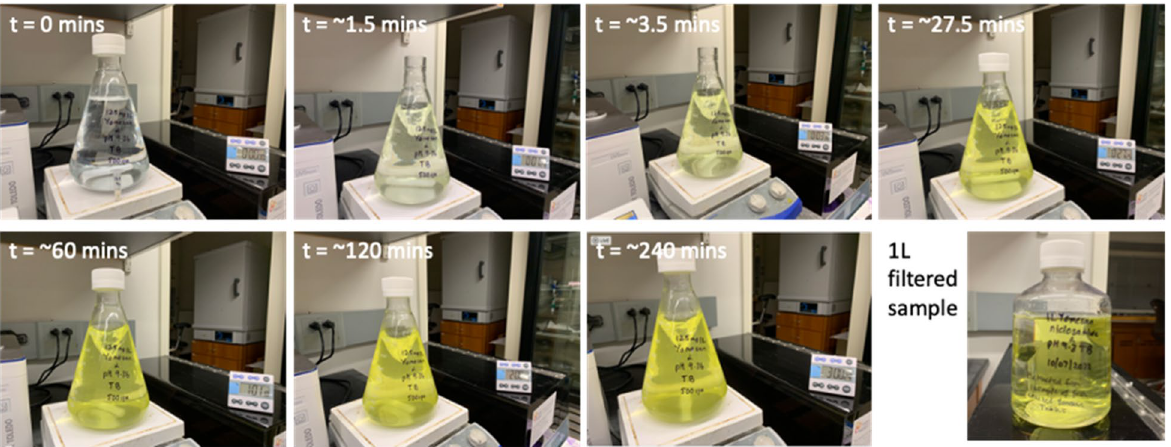
Fig. 20 Dissolution of Yomesan-niclosamide at 1 L scale showing the increasing yellowness of the solution as the niclosamide dissolves over a period of 0–180 min. Far right, the filtered 1 L sample of 165 µM niclosamide in final pH